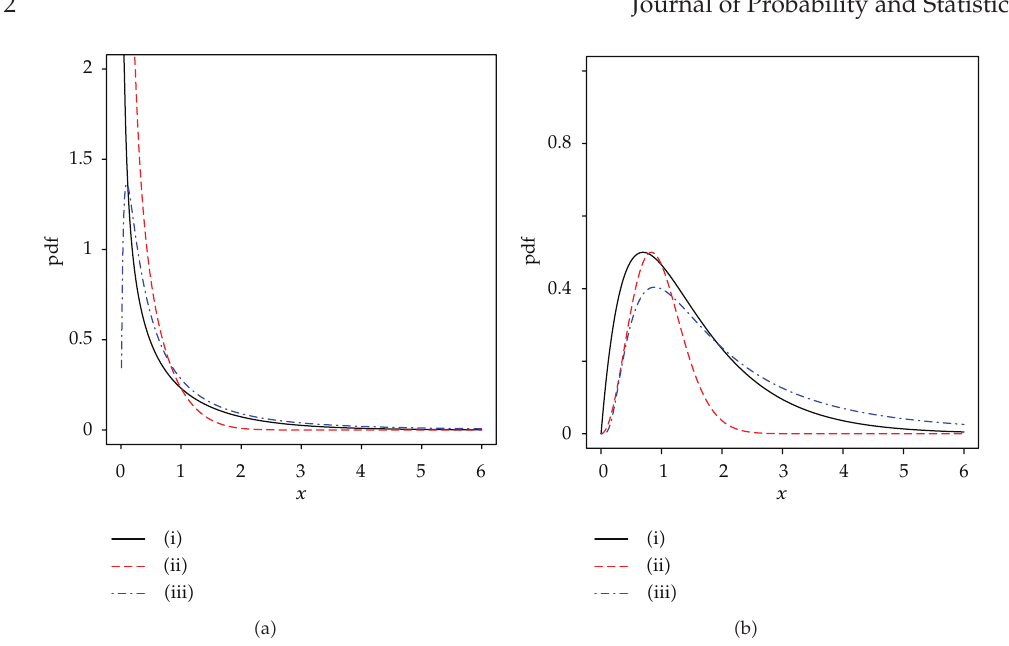
Figure 1: Exponentiated distributions for α (cid:5) 0 . 5 and α (cid:5)